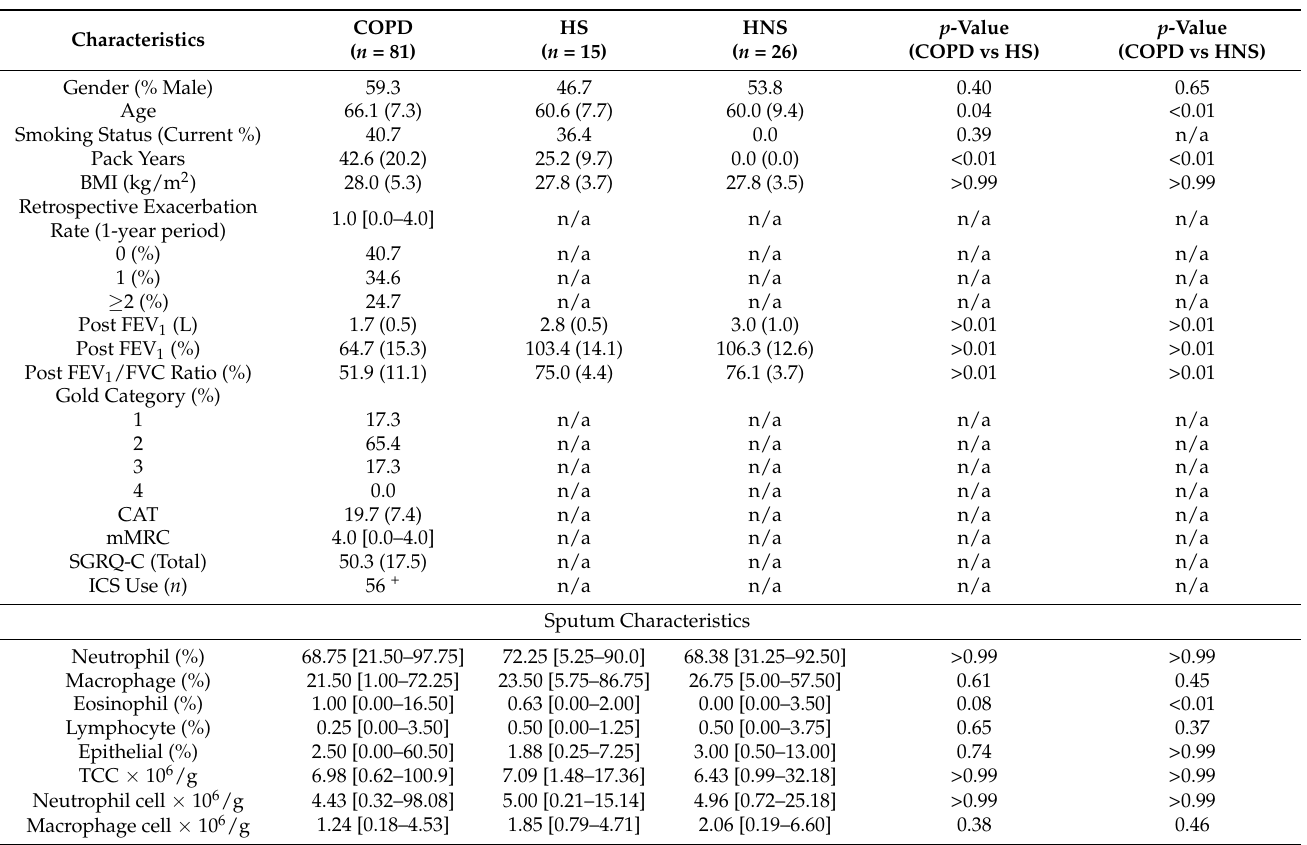
Table 3. Baseline characteristics for COPD subjects, healthy smoking and healthy non-smoking controls in Cohort B ( n = 81, 15 and 26, respectively *).